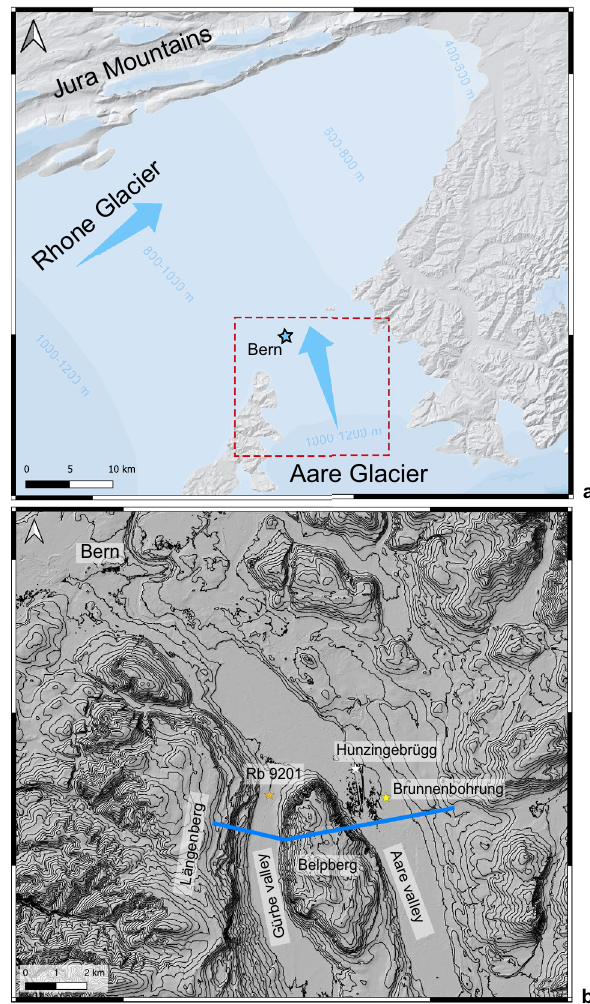
Figure 1. LGM glaciers and modern topography. ( a ) Map 21 showing the extent and thicknesses of the glaciers that shaped the landscape of the study area during LGM times. This map was taken and modified from the openly accessible database of swisstopo (© swisstopo). ( b ) Topographic map illustrated as hill shaded DEM (SwissAlti3D, © swisstopo), showing the drilling locations in the Gürbe valley (RB9201) and two drillings in the Aare valley (Brunnenbohrung Münsingen, drilling Hunzigebrügg). The equidistance of the contour lines is 20 m. The map also shows the bedrock ridges (Belpberg, Längenberg) that framed the flow of the glaciers. Both datasets are available from the openly accessible database of